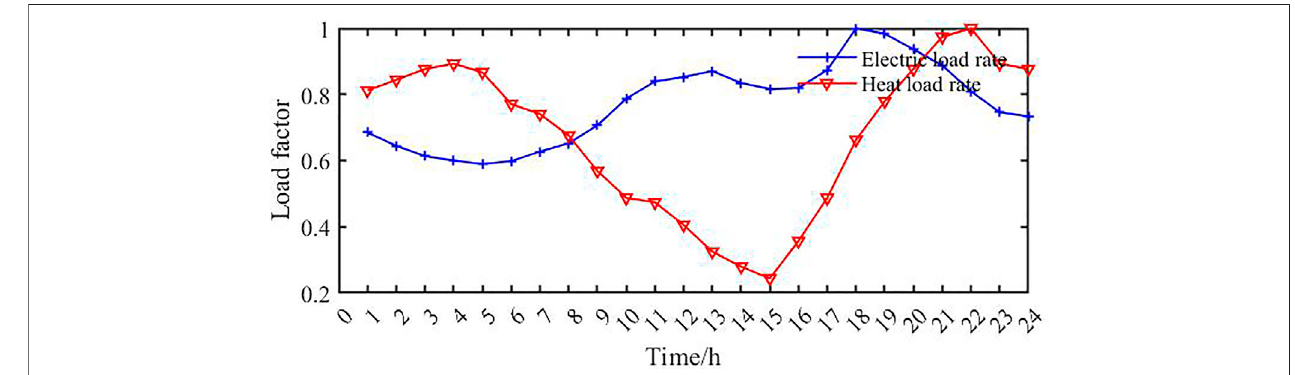
FIGURE 6 | Forecast values of electric and heat load rate during the day to be dispatched.